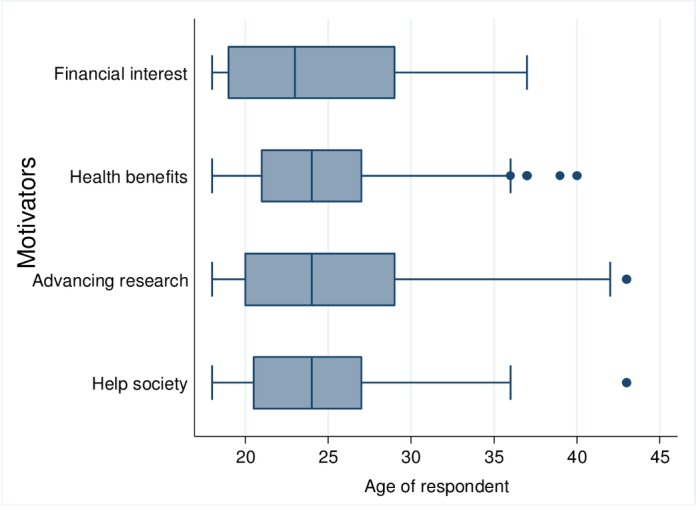
Age and motivators.